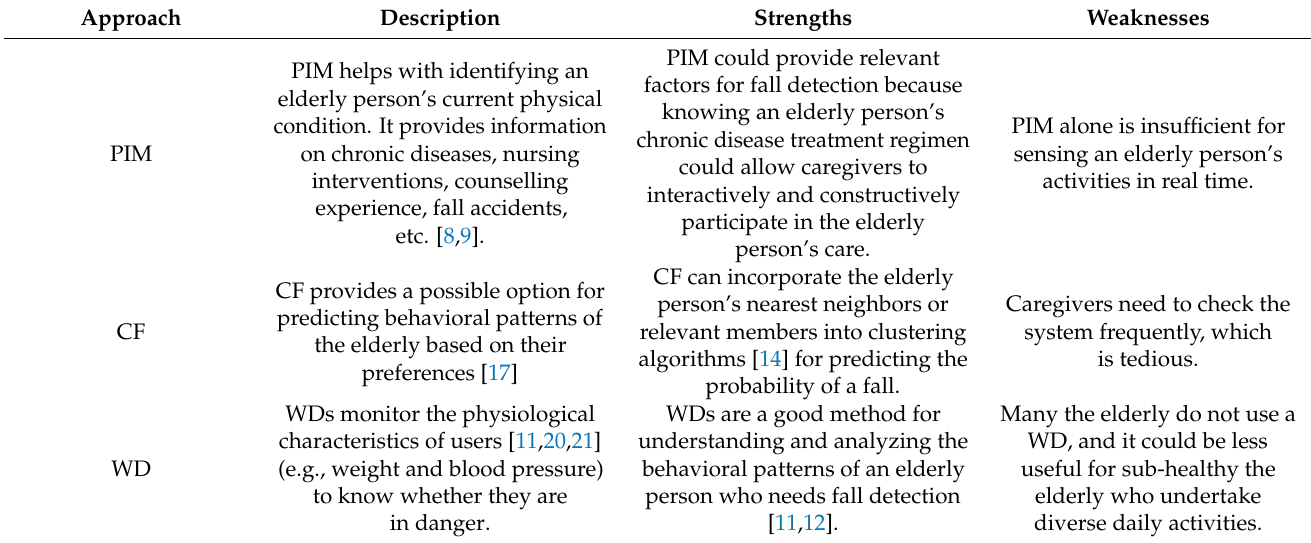
Table 1. A summary of existing